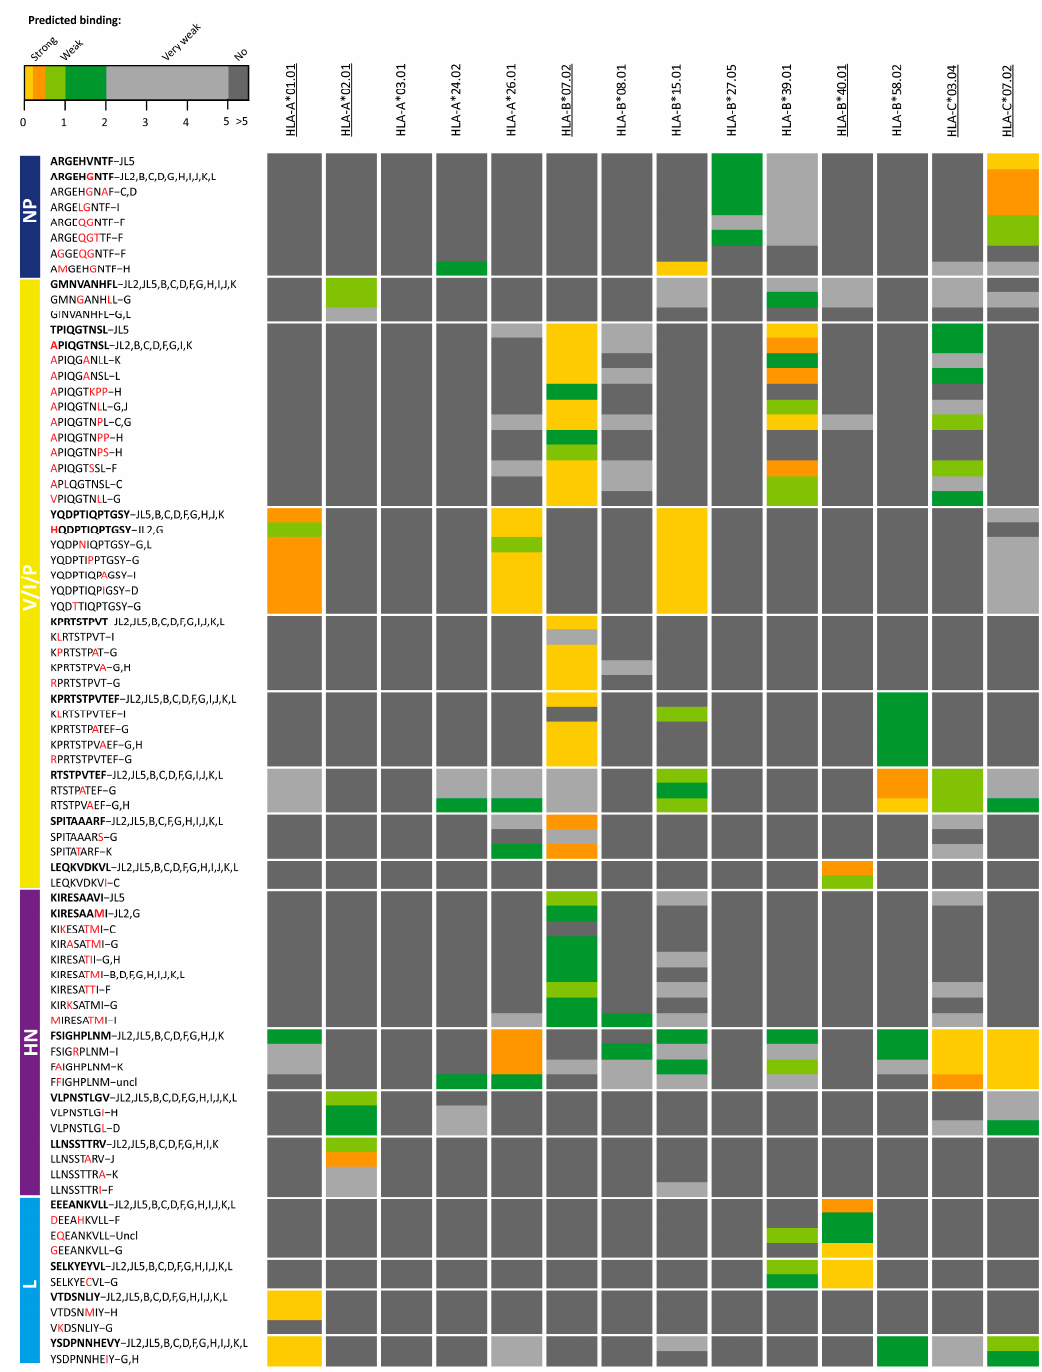
1 Figure 2. Heat map of epitope candidates of the JL2/JL5 mumps vaccine viruses in which amino acid sequence variants were found in circulating strains that led to reduced predicted binding to human leukocyte antigen Class I (HLA-I) molecule(s). Color scale indicates differences in predicted HLA-I binding peptides with lower rank (yellow) representing strong predicted HLA-I binding and dark grey no binding (>5% rank). Bars on the left indicate proteins where epitope candidates are part of. Epitope variants detected in Jeryl Lynn (JL) mumps vaccine strains are indicated as the first variant of each epitope and in bold. Behind each epitope variant is also indicated in which genotype(s) epitope variants were detected (uncl = unclear; Mumps rubulavirus—UniProt KF878082). Differences in amino acid sequences compared to epitope candidates of the JL2/JL5 mumps vaccine viruses are indicated with red character. HLA-I molecules that were expressed by the cell line used to identify the epitope candidates are underlined. NP, nucleoprotein; V/P/I, V/phospo (P)/I proteins; M, matrix protein; F, fusion protein; SH, small hydrophobic protein; HN, hemagglutinin-neuraminidase; L, large